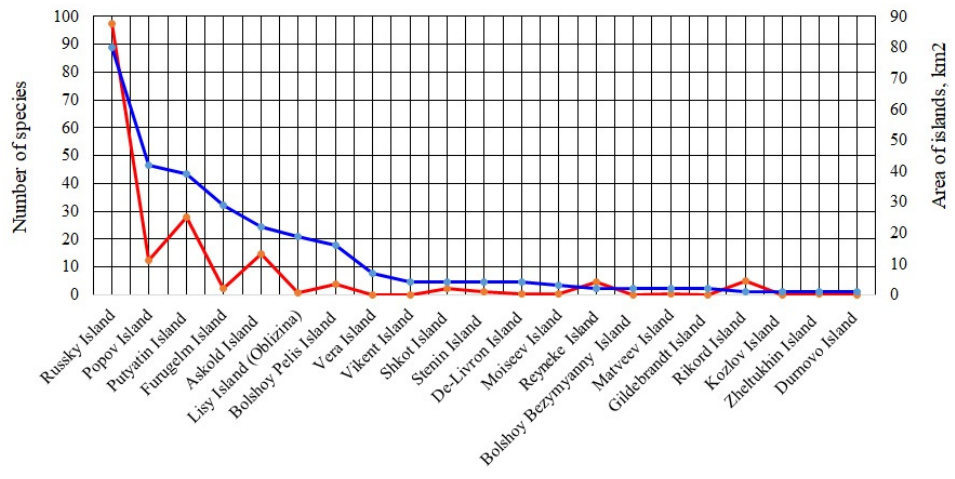
Figure 3. Dependence of taxonomic diversity of Scarabaeoidea on the area of islands in Peter the Great Gulf. Note: The area of the islands is indicated in red, and the number of species is indicated in blue.